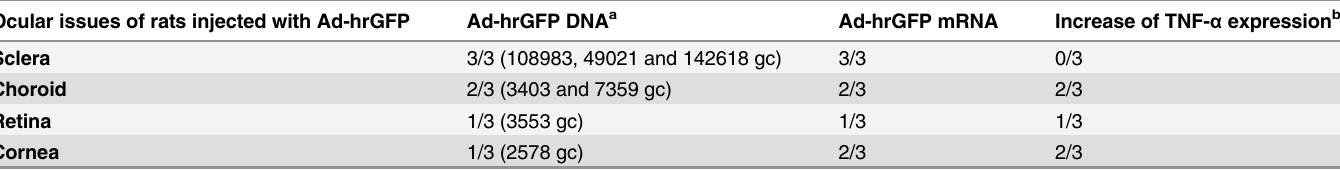
a Numbers in round bracket indicates viral genome copies per μ g of total DNA of the tissue b More than two fold of increase in comparison with PBS injected rats.